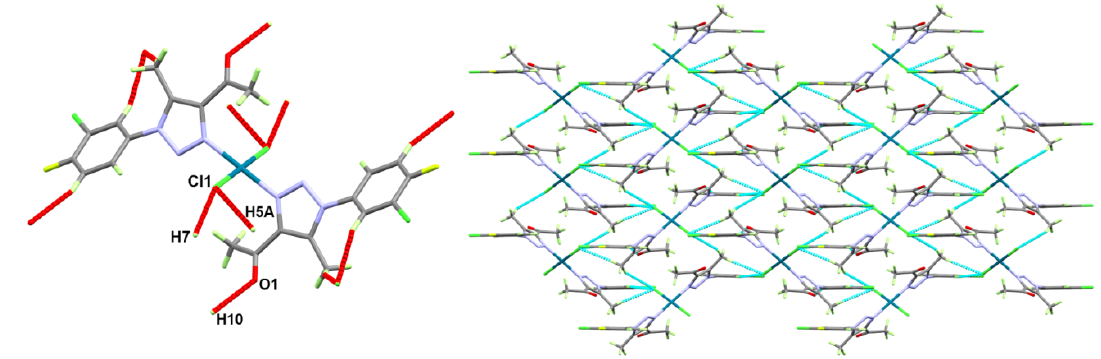
Figure 5. Packing view of [Pd( 3 ) 2 Cl 2 ] via C–H...O and C–H...Cl interactions.